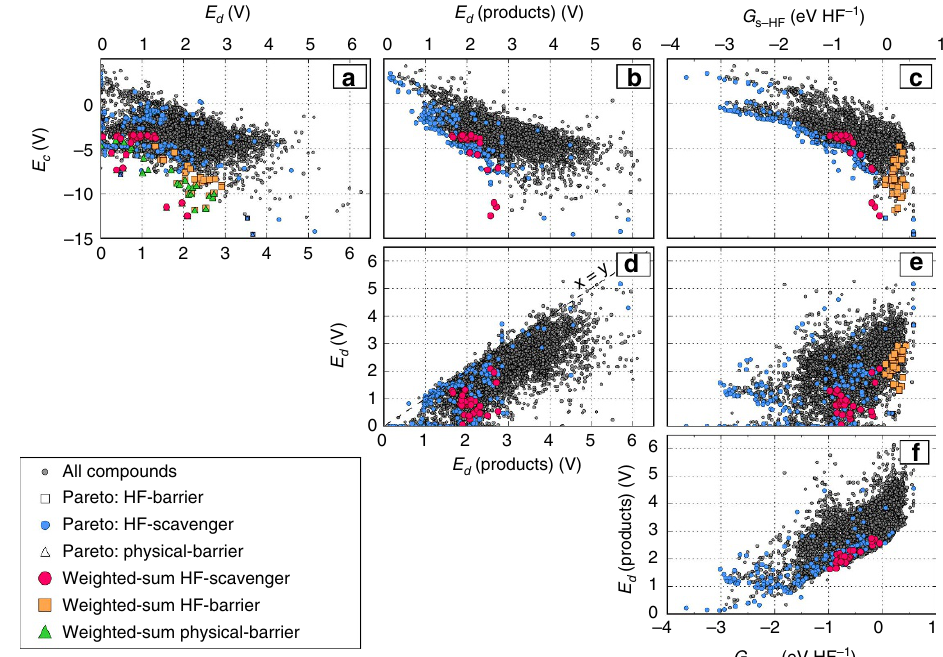
Figure 4 | Matrix plot of attributes employed within the coating design framework for pair-wise comparison. Panels a – f represent each unique attribute pair. Based on the ideal trends of attributes for different types of coatings listed in Table 1, materials on the Pareto-front for each coating type are determined. Top 30 coating materials found by weighted-sum method are also shown for each coating method, and represent a viable set of solutions for the MOOP. list with both methods.